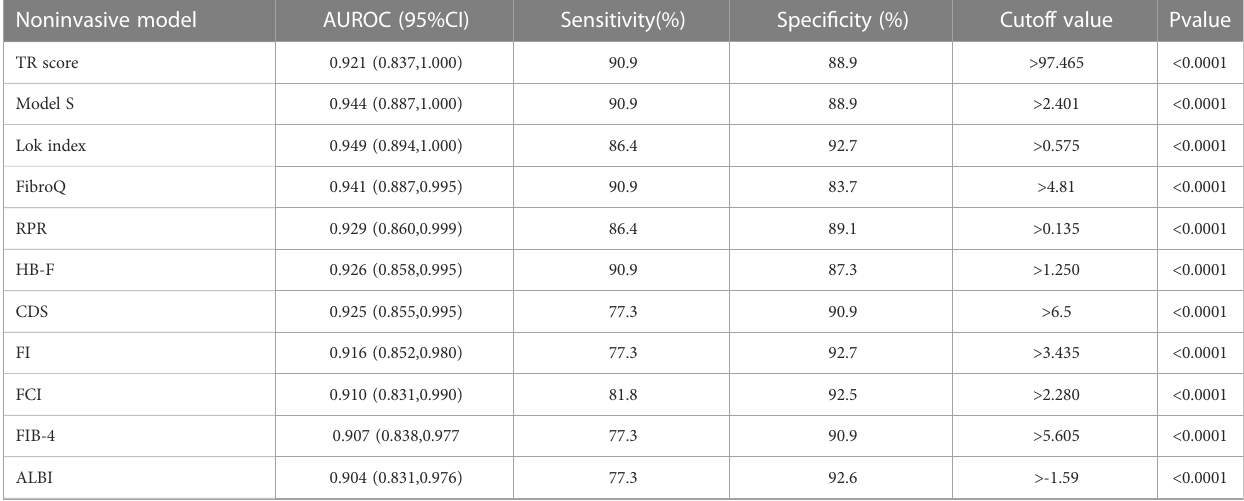
TABLE 7 Validity of each models for prediction of cirrhosis